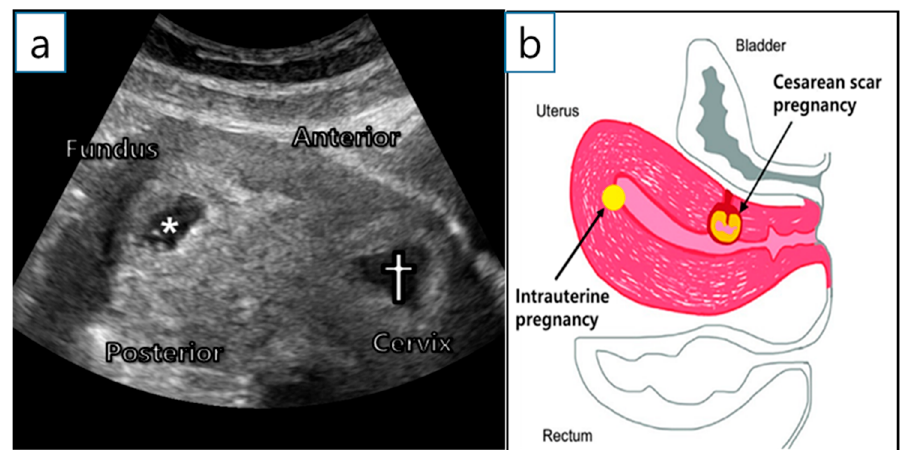
Figure 1. Initial examination. ( a ) Initial transvaginal ultrasound examination at 6 +1 GW. *—intrauterine gestational sac; †—CSP. ( b ) Description of sagittal plane.